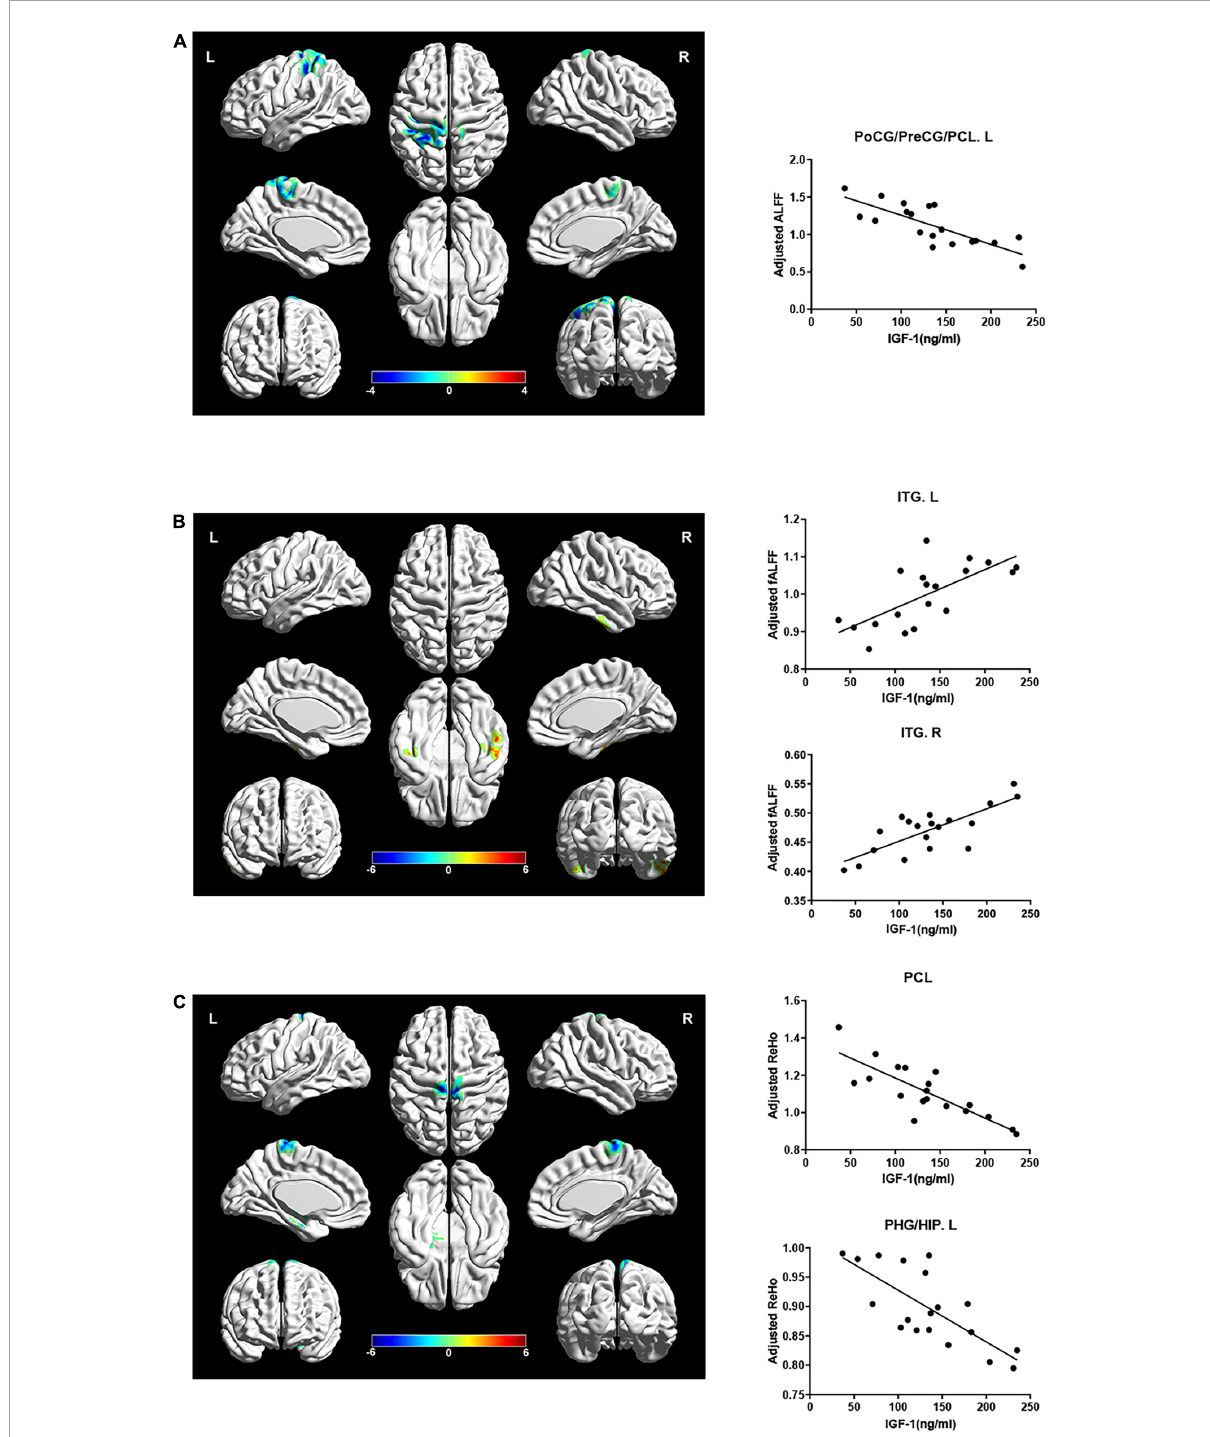
FIGURE4 Correlations between local brain activity indexes (ALFF, fALFF, and ReHo) and serum IGF-1 levels in specific regions. Hot color indicates a significant increase, while cold color indicates a significant decrease in those with a high serum IGF-1 levels. (A) ALFF in PoCG/PreCG/PCL.L were negatively correlated with serum IGF-1 levels ( r = –0.326, P = 0.032) after adjusted for age, gender and group. (B) fALFF in ITG were positively correlated with serum IGF-1 levels (ITG.L: r = 0.832, P < 0.001; ITG.R: r = 0.796, P < 0.001) after adjusted for age, gender and group. (C) ReHo in PCL and PHG/HIP.L were negatively correlated with serum IGF-1 levels (PCL: r = –0.790, P < 0.001; PHG/HIP.L: r = –0.803, P < 0.001) after adjusted for age, gender and group. IGF-1, insulin-like growth factor-1; ALFF, amplitude of low frequency fluctuation;